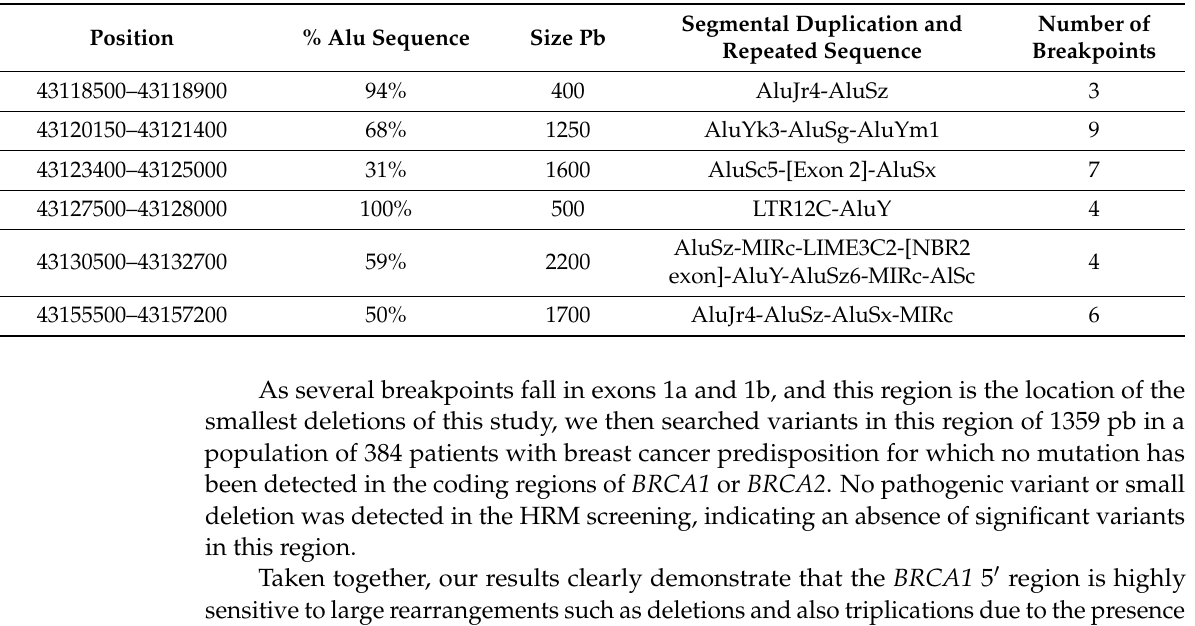
Table 5. Description and size of the five sensitive regions with hotspot of recombination in the rearrangements reported in this report and in the